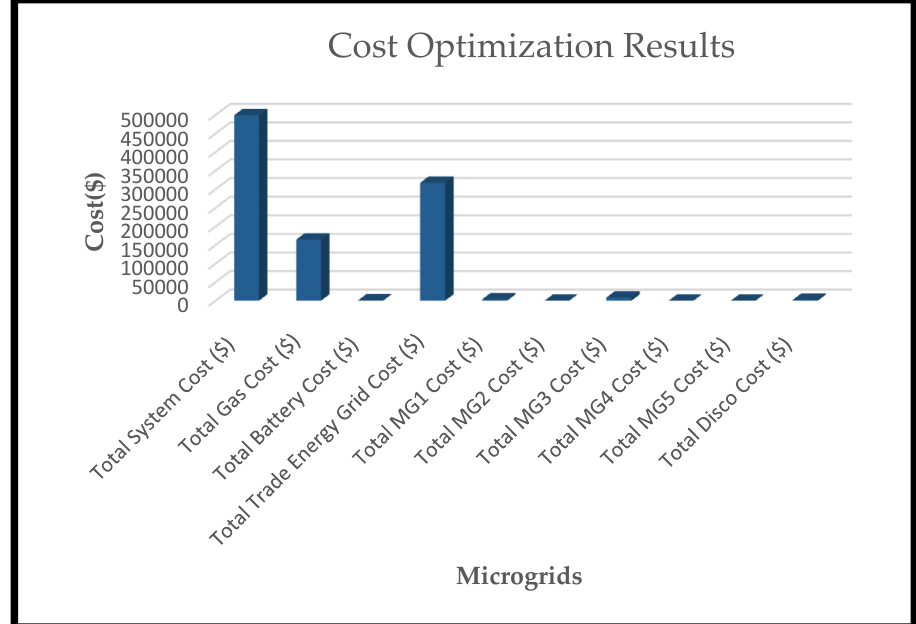
Figure 15. Cost optimization results.